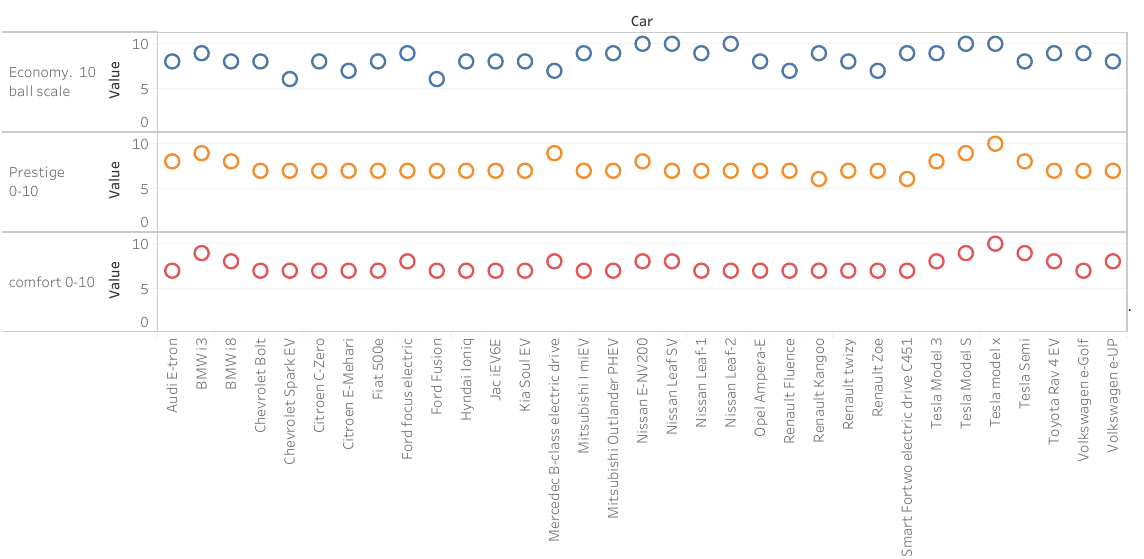
Figure 5. Diagram of dependence of profitability of